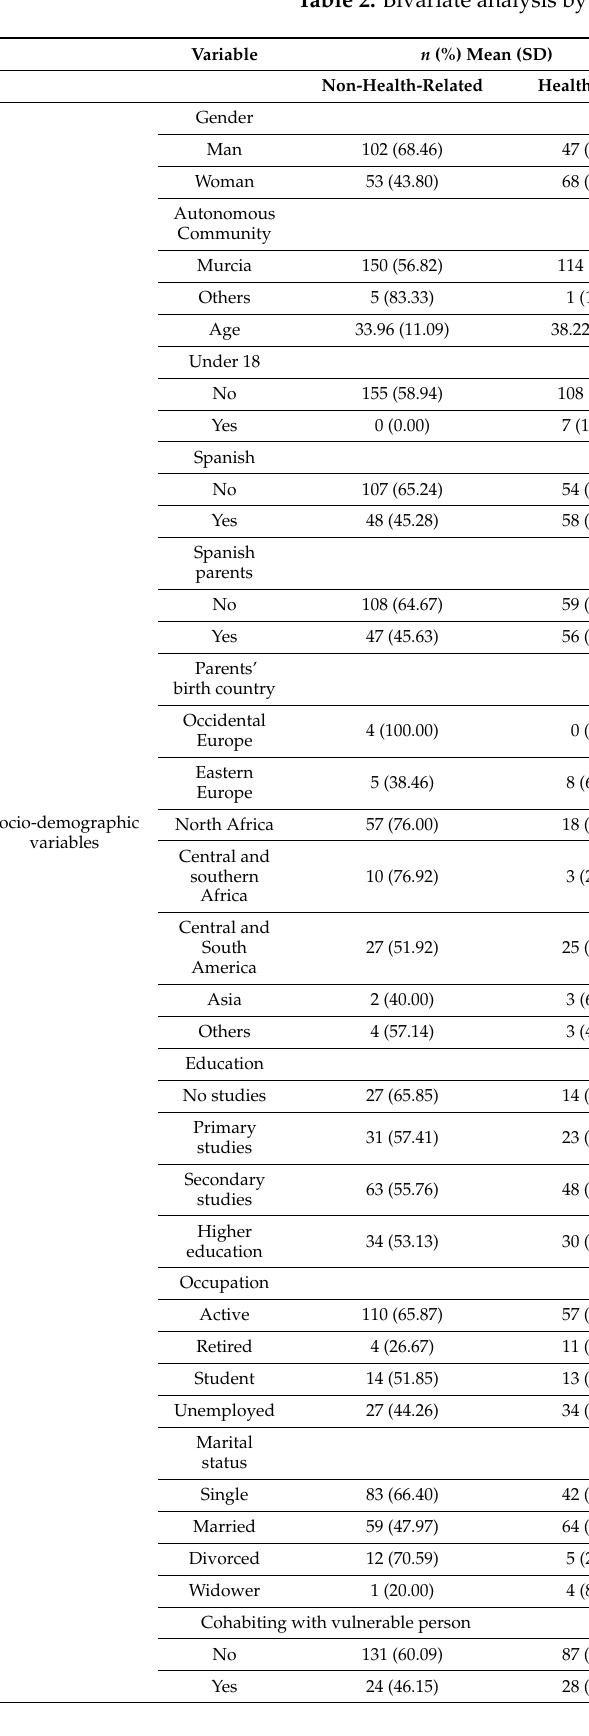
Table 2. Bivariate analysis by reason for vaccination (socio-demographic